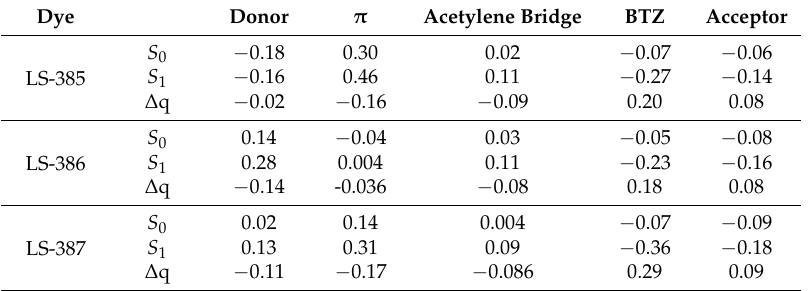
Table 3. Natural Bond Orbital Analysis (Atomic Charge in a.u.) for the Ground State ( S 0 ) and Excited State ( S 1 ) of the dyes with D- π -A- π -A